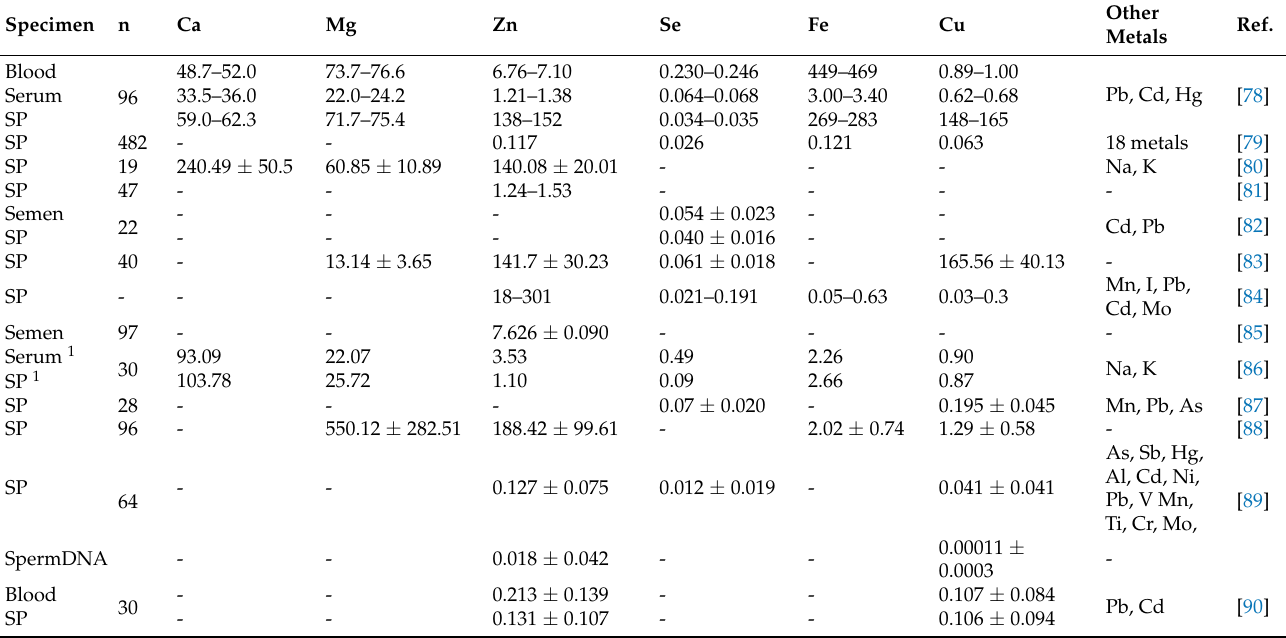
Table 1. Concentrations of trace elements (mg L − 1 ) in normal semen specimens or other biological materials taken from fertile